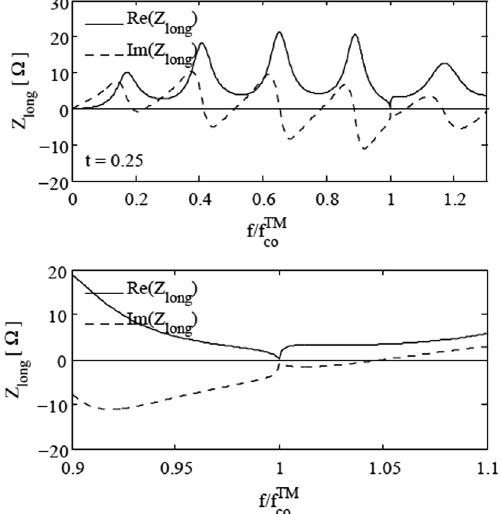
FIG. 12. Real part of the impedance for thickness t ¼ 25 cm. The different behavior at cutoff is clearly visible. b ¼ 5 cm,